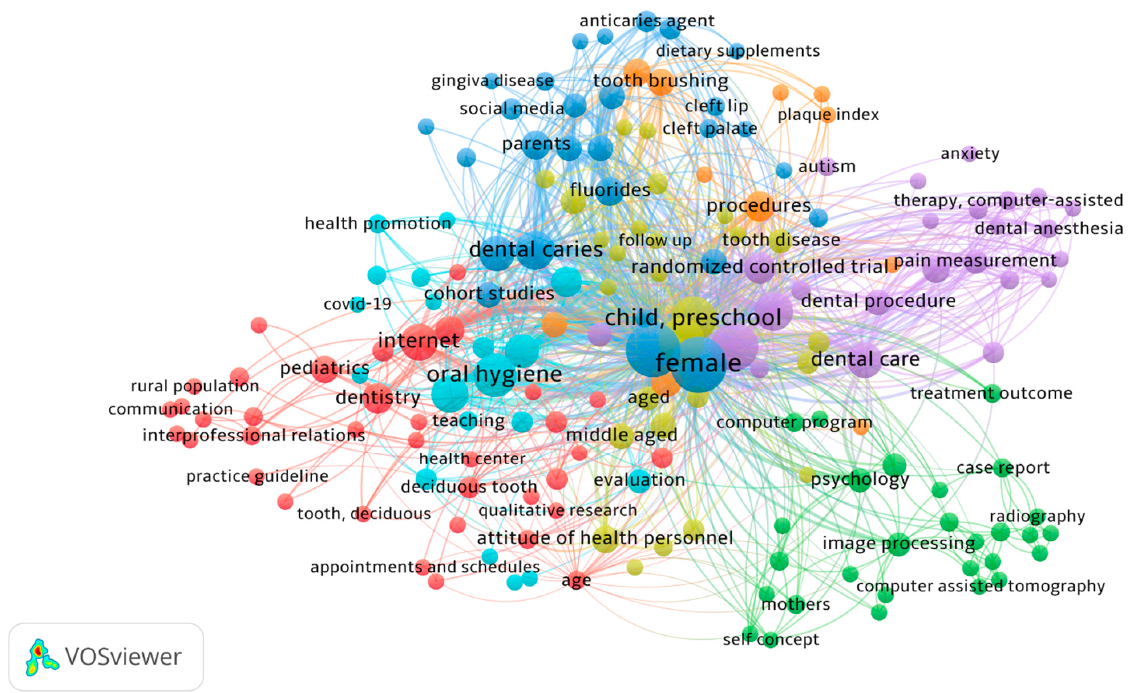
Figure 6. Network visualization map of the index keywords (keyword threshold = 2; display 174 out of 559 keywords). Each colour represents different patterns of co-occurrences based on multiple keywords retrieved from the dataset.